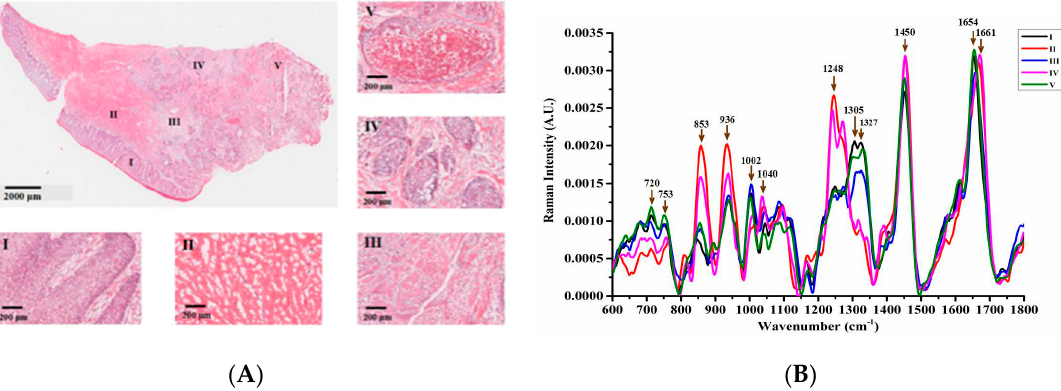
Figure 1. ( A ) shows the hematoxylin and eosin (H&E) stained image of the primary squamous cell carcinoma (SCC) lesion. In that, the symbols I–V mark the di ff erent lesion area. The magnified image of the typical epidermis is marked as region I; collagen fiber reticulation in region II indicates a typical dermal layer structure; region III lies between the dermis and the mature tumor mass; the neoplasia occurring in the dermis area IV; and necrotic tissue mass is presented in region V; ( B ) shows normalized mean spectra of di ff erent areas for primary SCC lesion, in which the arrows point to some prominent Raman